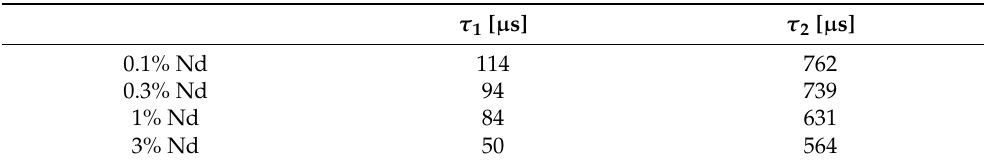
Figure 6. Decay curves of LaMgAl 11 O 19 :Nd under X-ray irradiation. The sensitivity of the used photomultiplier tube covers 380–920 nm. Table 2. Decay time constants of first ( τ 1 ) and second ( τ 2 ) components calculated from the decay curves under X-ray irradiation.